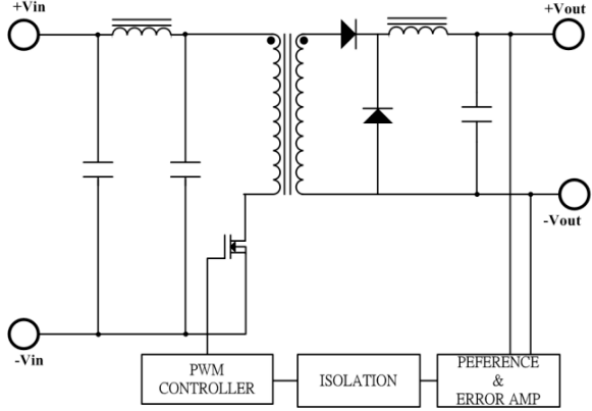
Figure 2. Schematic circuit of the forward converter [11].